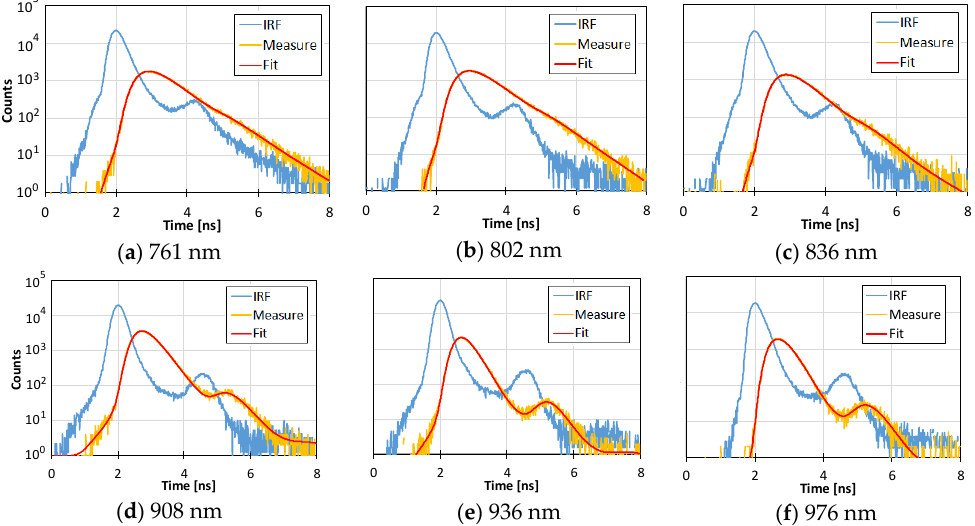
Figure 4. Examples of IRFs (blue lines), measured temporal profiles (yellow lines), and the fitting results (red lines) at 6 wavelengths (761 nm (a), 802 nm (b), 836nm (c), 908 nm (d), 936 nm (e), and 976 nm (f)) obtained from TD-DOS measurement of normal breast tissue with O 2 Hb = 14.6 μM, HHb = 3.9 μM, water content = 15.4%, and lipid content = 63.9%.